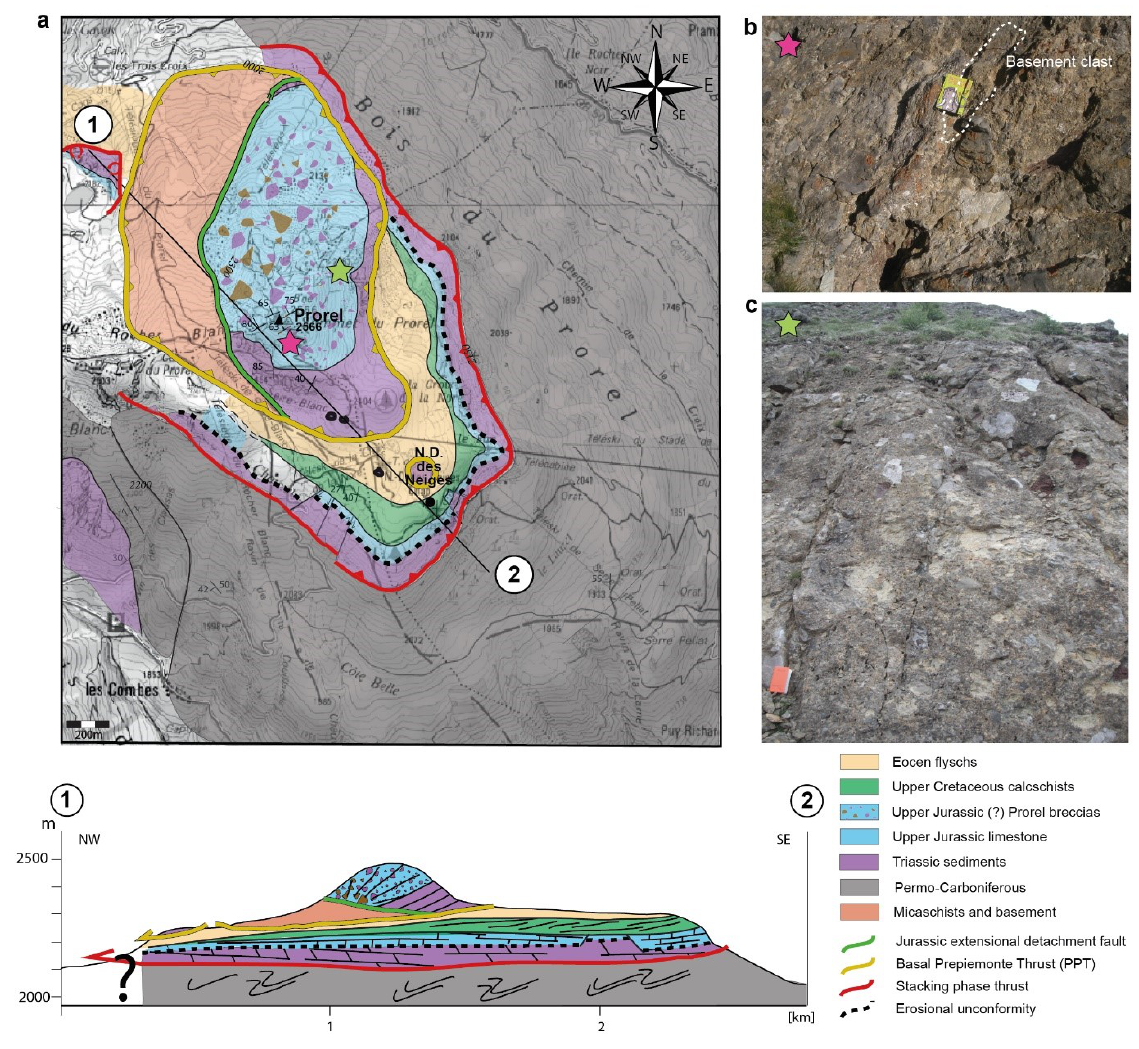
Figure 8. ( a ) Map and geological section (1) – (2) across the Prorel summit located west of Briançon. The Prorel summit is formed by breccias of supposed Jurassic age that overlie Triassic limestone/dolostone. This sedimentary sequence unconformably overlie a basement made of chlorite-rich micaschists. The contact in-between (green line in the figure) was interpreted as a reactivated Jurassic detachment fault (see text for details and discussion); ( b ) photograph of the polygenic breccias of the Prorel summit, including both pre-rift sediment- and basement clasts; ( c ) photograph of the monogenic breccias of the Prorel summit, including only pre-rift sediment clasts.